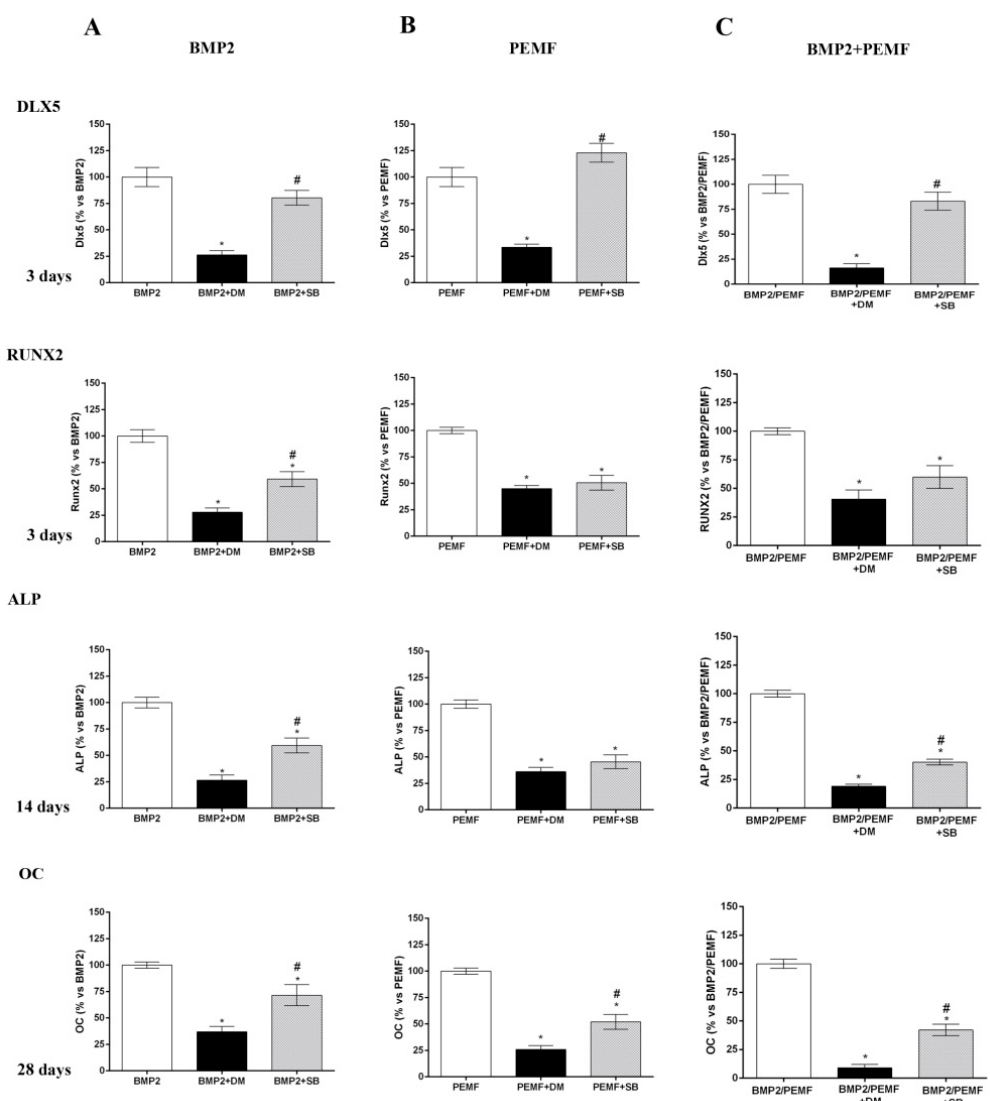
Figure 6. Effects of DM (5 μ M) and SB203580 (10 μ M) on hMSCs differentiated ( A ) in OM + BMP2, ( B ) in OM + PEMFs, ( C ) in OM + PEMFs + BMP2. DLX5 and RUNX2 gene expression (3 days), ALP activity (14 days), and OC production (28 days) evaluated. *: p ≤ 0.05 vs. cells differentiated in the absence of inhibitor treatment. #: p ≤ 0.05 vs. cells differentiated in the presence of DM.